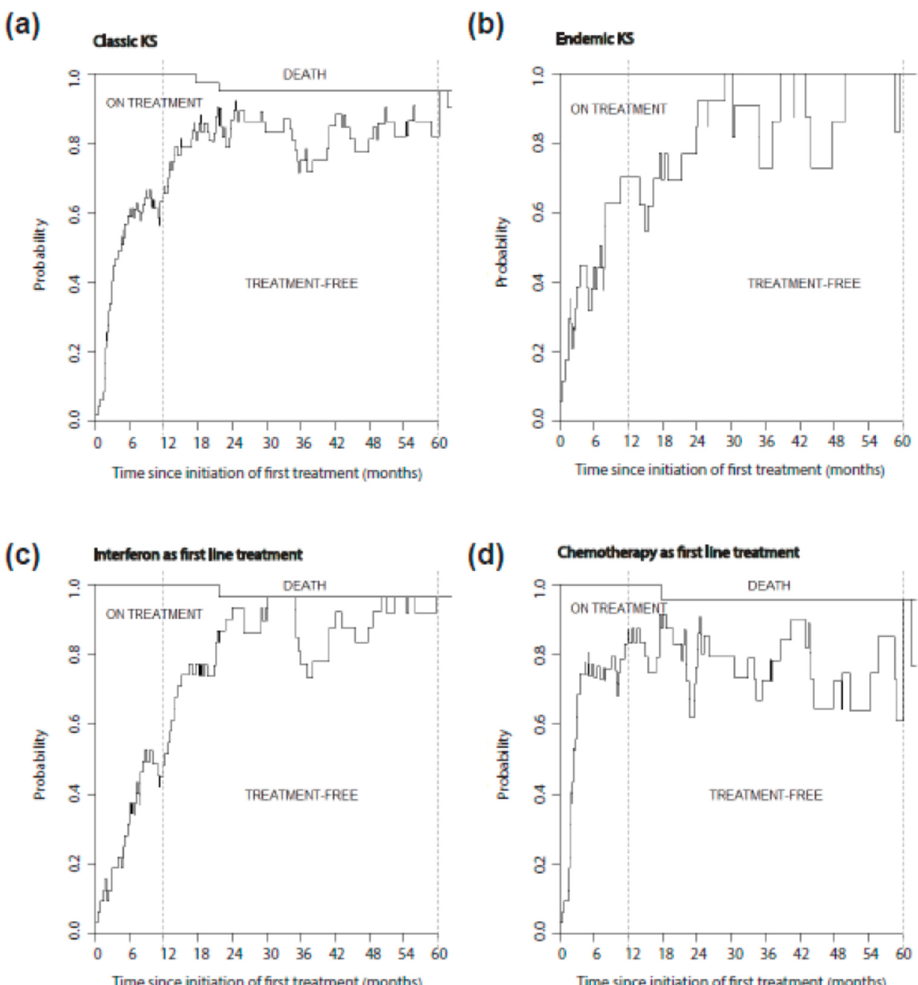
Figure 5. Treatment free time after systemic treatment initiation in classic/endemic KS patients stratified according to KS subtype: classic ( a ) or endemic ( b ), or according to type of first line treatment: interferon ( c ) or chemotherapy ( d ). This figure was generated using state occupation probabilities: the area under the curve represents the mean time spent alive, on treatment and alive treatment-free during the first 5 years following the initiation of first systemic treatment. Dotted lines correspond to 1 and 5 years after first treatment initiation.